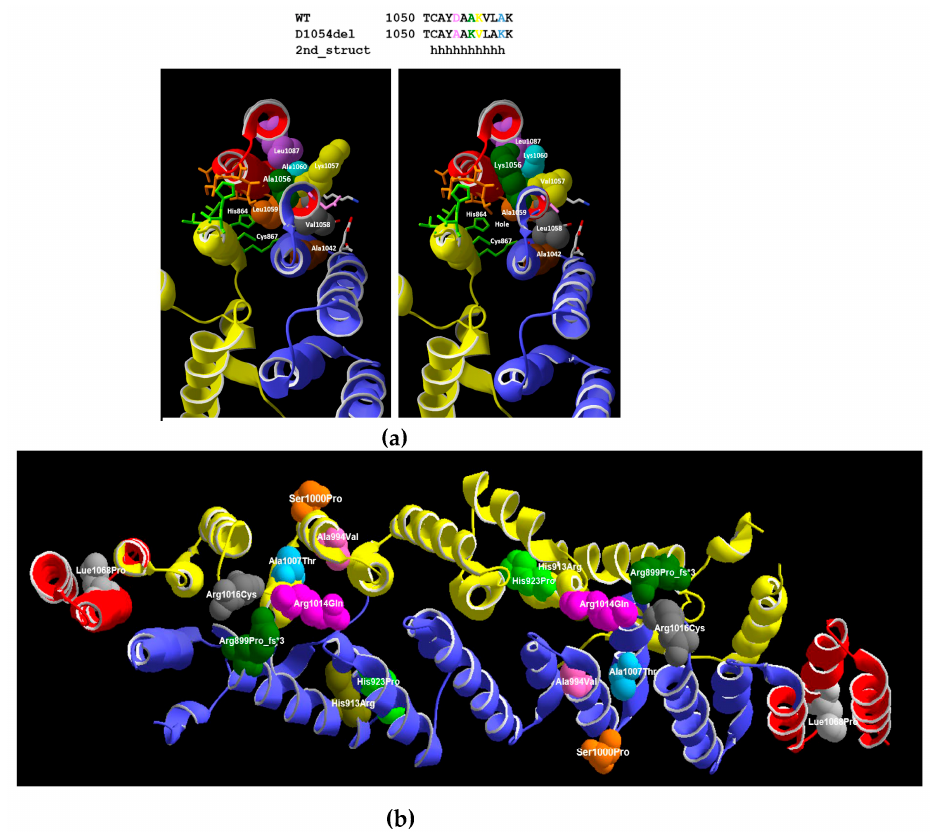
Figure 2. Figure 2. 3D-protein modeling of GEMIN5 variants. ( a ) The predicted effect of the NM_015465.5 (NP_056280.2):p. (Asp1054_Ala1055delinsGlu) variant. On the left is the wild-type protein, and on the right is the mutated one. NM_015465.5 (NP_056280.2):p. (Asp1054_Ala1055delinsGlu) is indicated